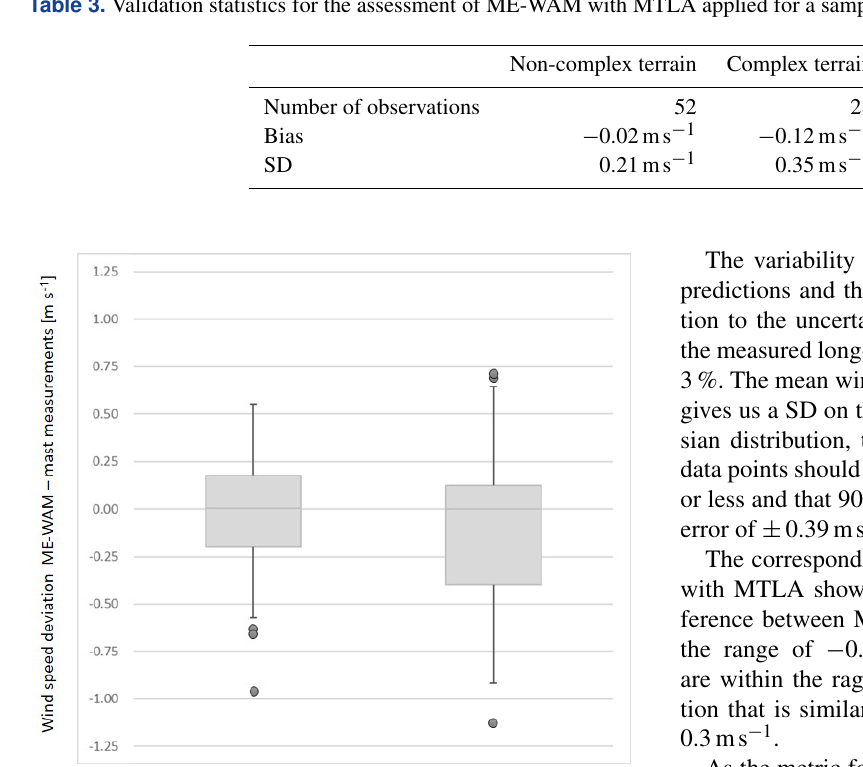
Table 3. Validation statistics for the assessment of ME-WAM with MTLA applied for a sample of 45 data points.